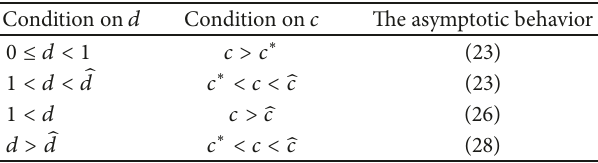
Table 1: The asymptotic behavior of the wave profile (𝑈, 𝑉) near